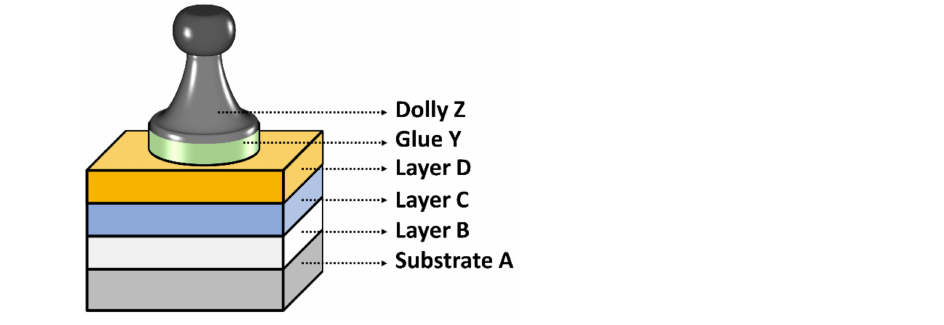
Figure 3. Schematics of the coated substrate and their designation in the analysis of the fracture mode.